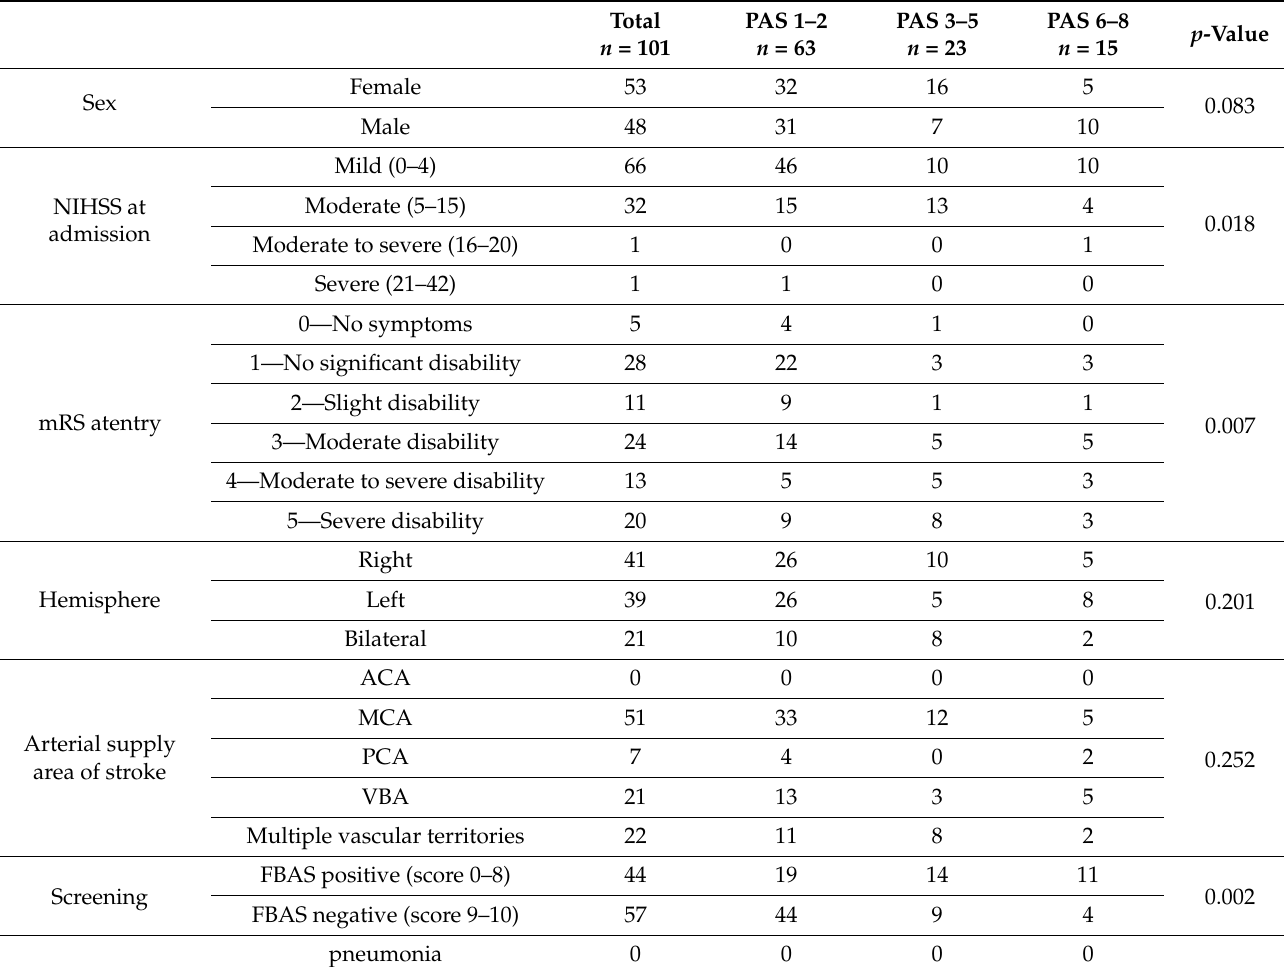
Table 2. Patients’ clinical